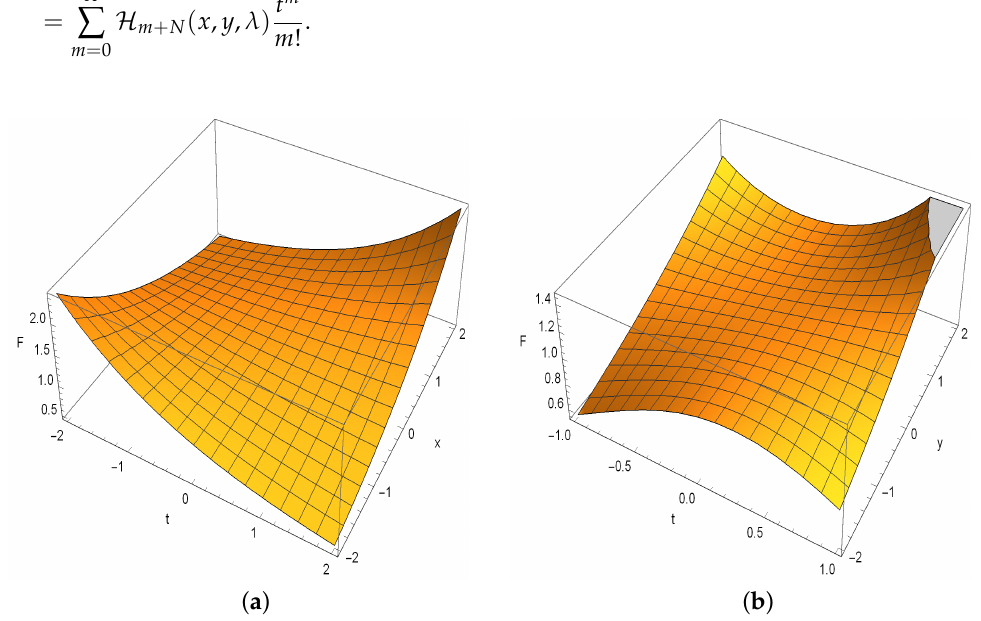
Figure 1. The surface for the solution of F ( t , x , y , λ ) = 0. ( a ) − 2 ≤ x ≤ 2, − 2 ≤ t ≤ 2, λ = 1/2, and y = 0.1; ( b ) − 2 ≤ y ≤ 2, − 1 ≤ t ≤ 1, λ = 1/2, and x =